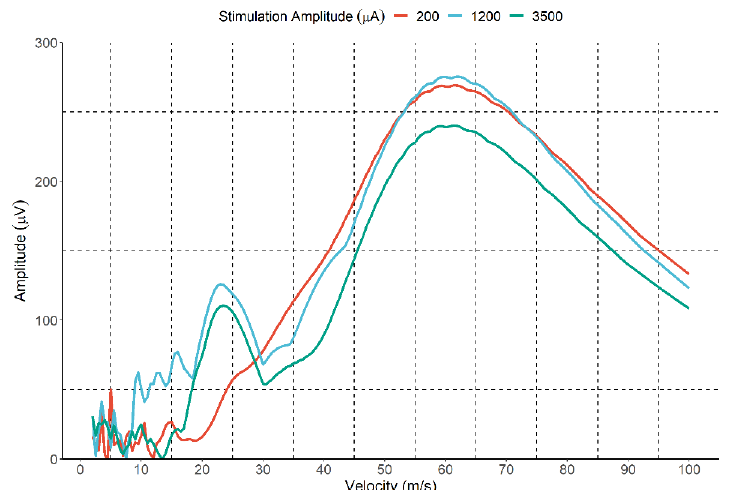
Figure 4. Excitation of fast and slow fibres by high stimulation intensity. In red, it is possible to see the activation of only the fast fibre group with a stimulation amplitude of 200 μA. At the intensity of 1200 μA (blue line), slow fibres are detected in the IVS, with a velocity of approximately 22 m/s. The IVS profile is maintained for the higher intensity of 3500 μA (green line). IVS profile is maintained for the higher intensity of 3500 µ A (green